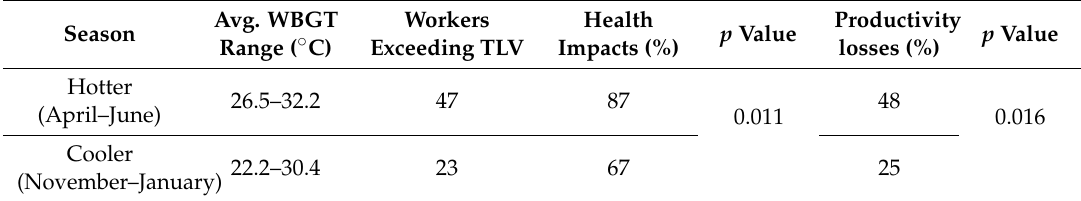
Table 4. Repeat measures of workers ( n = 72) perception on health and productivity losses during hotter and cooler seasons in Indian